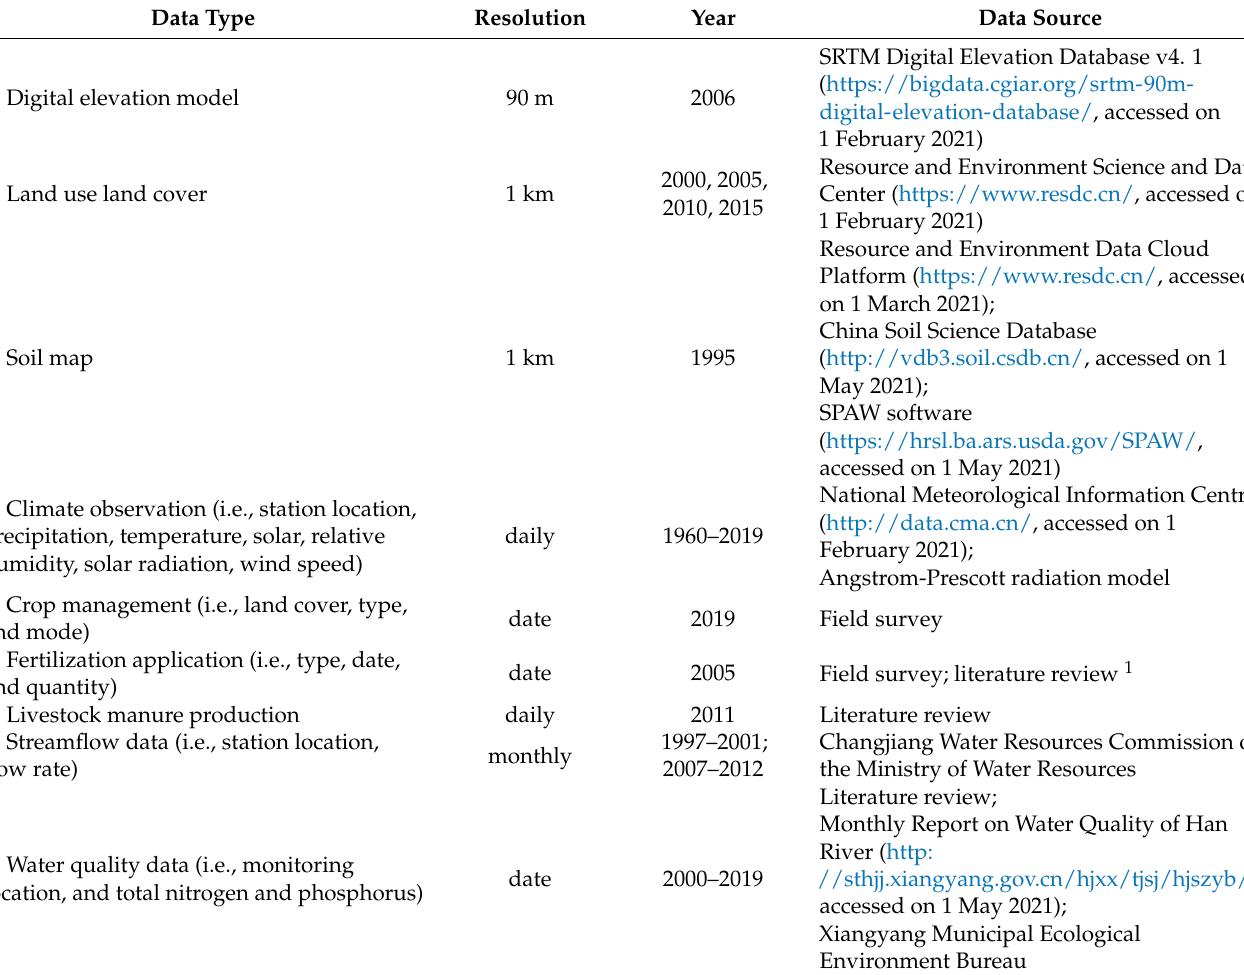
Table 1. Input and validation datasets, sources, and main